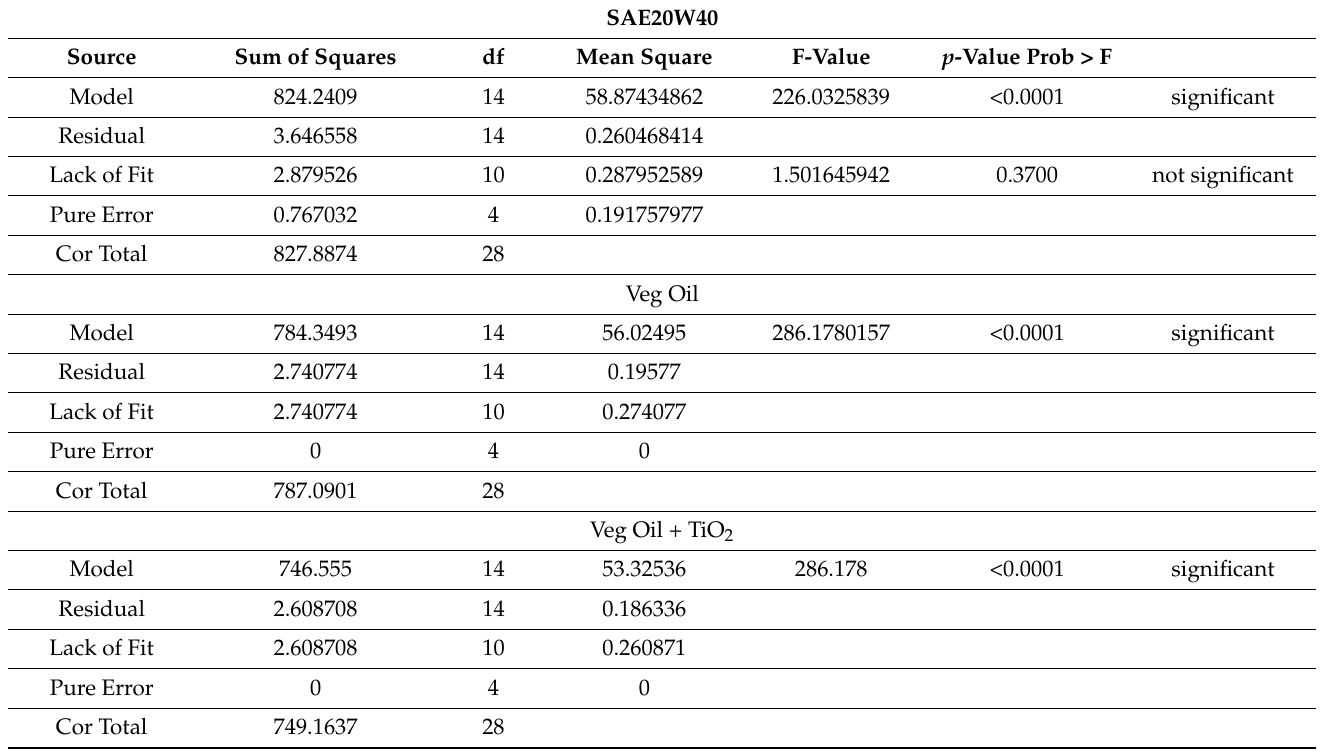
Table 10. ANOVA for temperature.